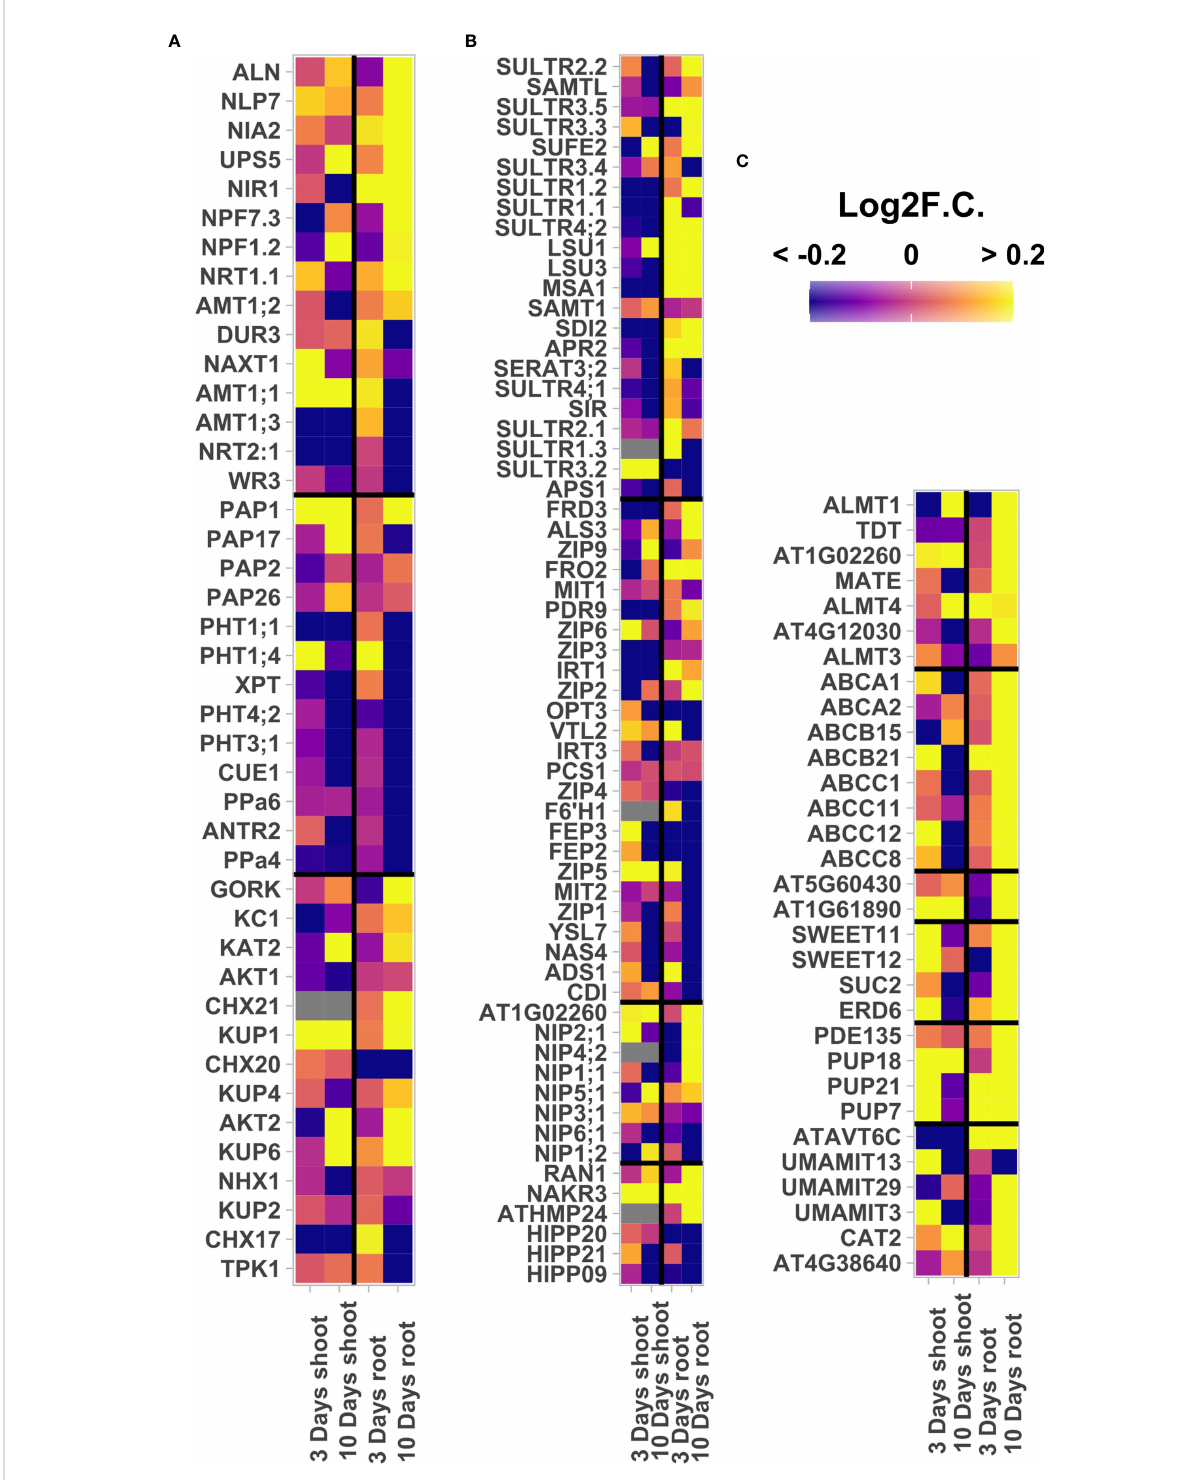
FIGURE 5 Effect of Titanium (Ti) on expression of nutrient acquisition related genes. Expression level (mean log2F.C.) of genes encoding transporters of (A) macro and (B) microelements, and other related molecules (C) . Gray squares indicate that the gene was fi ltered-out in the fi ltering step of the edgeR pipeline due to low CPMs. All heatmaps share the same color